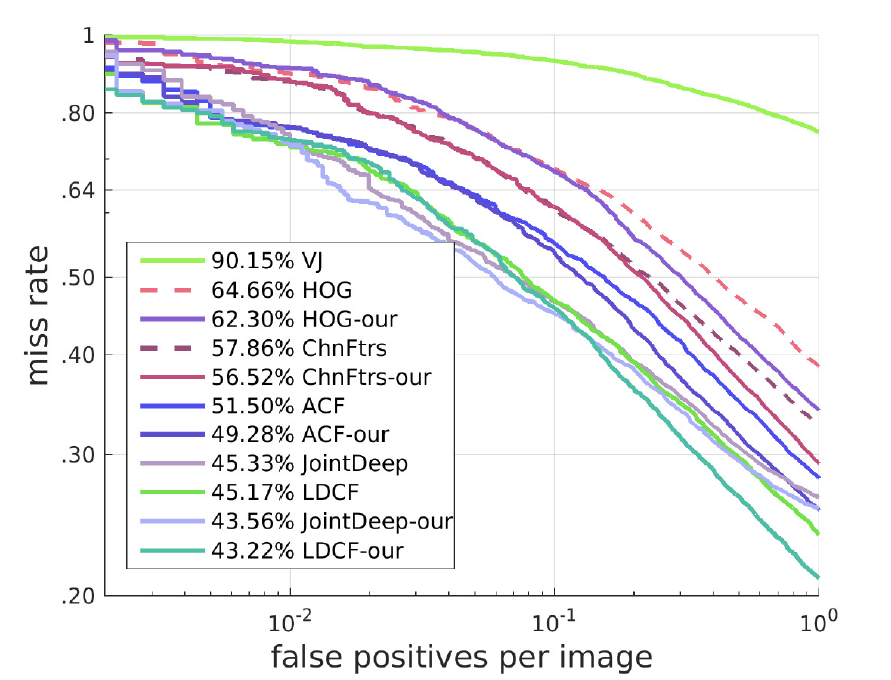
Figure 14. Results on the ETH Pedestrian Dataset.